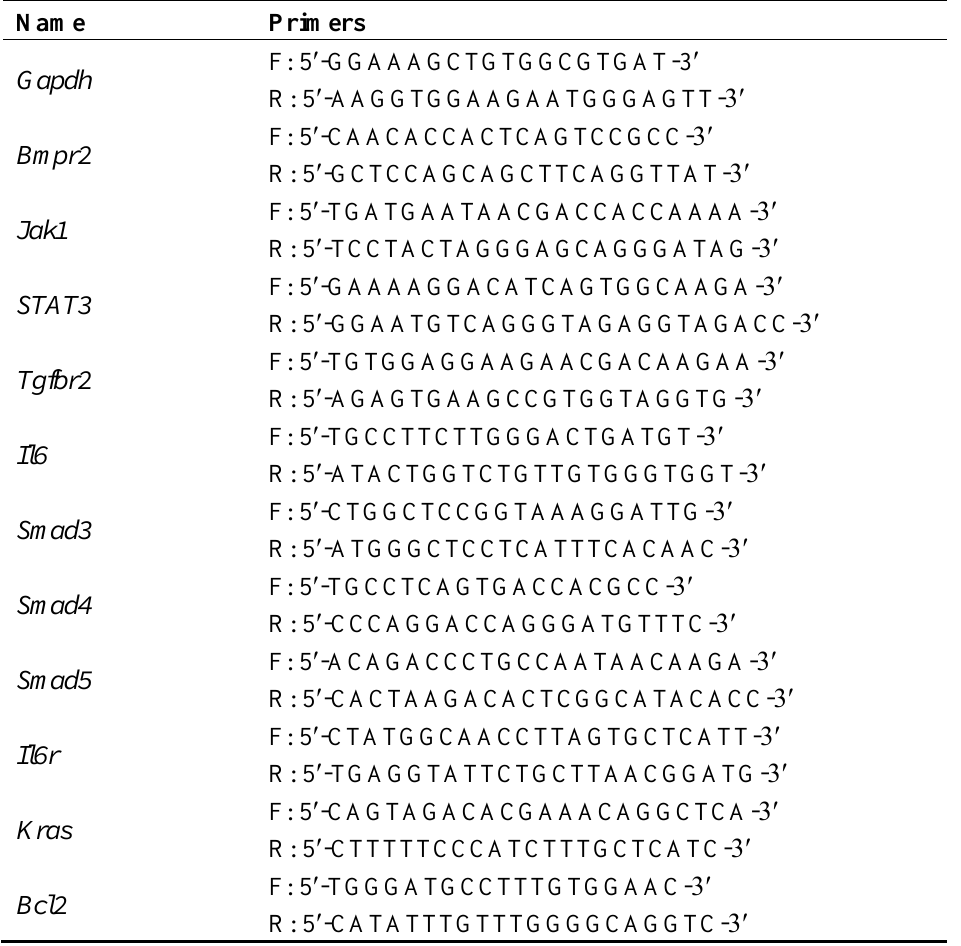
Table 2. Primers of mRNA